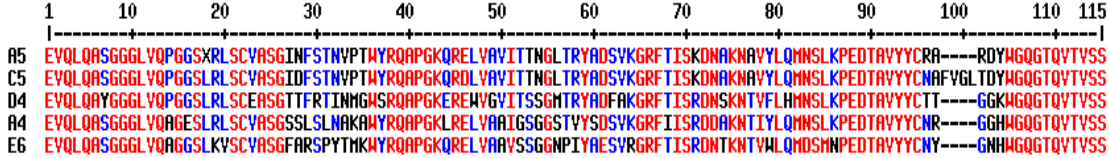
Figure 1. Deduced protein sequences of the five single-domain antibodies (sdAbs) that were evaluated. Sequences have been aligned using Multalin [32] to help identify similarities and differences in the protein sequence of the sdAbs. Red denotes high consensus and blue low consensus. Sequences are given in single letter amino acid code.